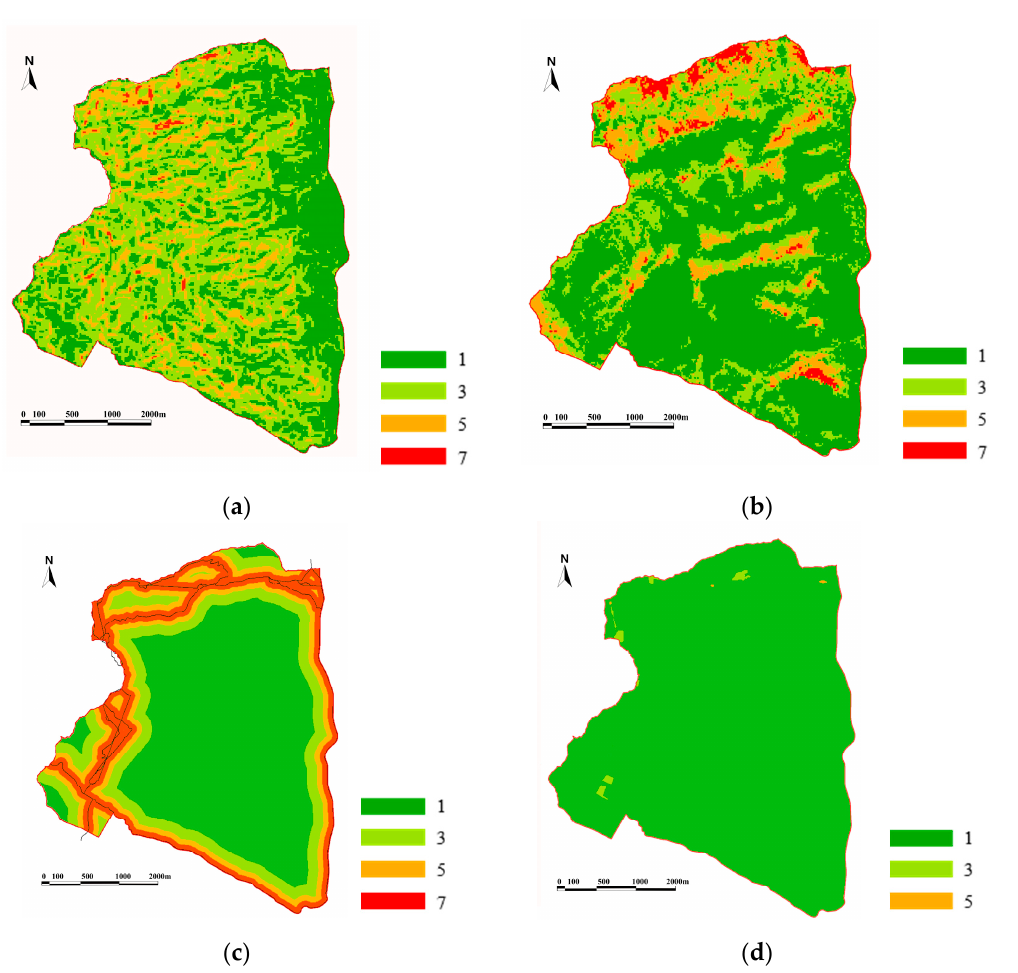
Figure 3. ( a ) Sensitivity of slope, ( b ) visual probability, ( c ) distance from the roads, and ( d ) remark- ableness degree. From 1 to 7 represents an increase in visual